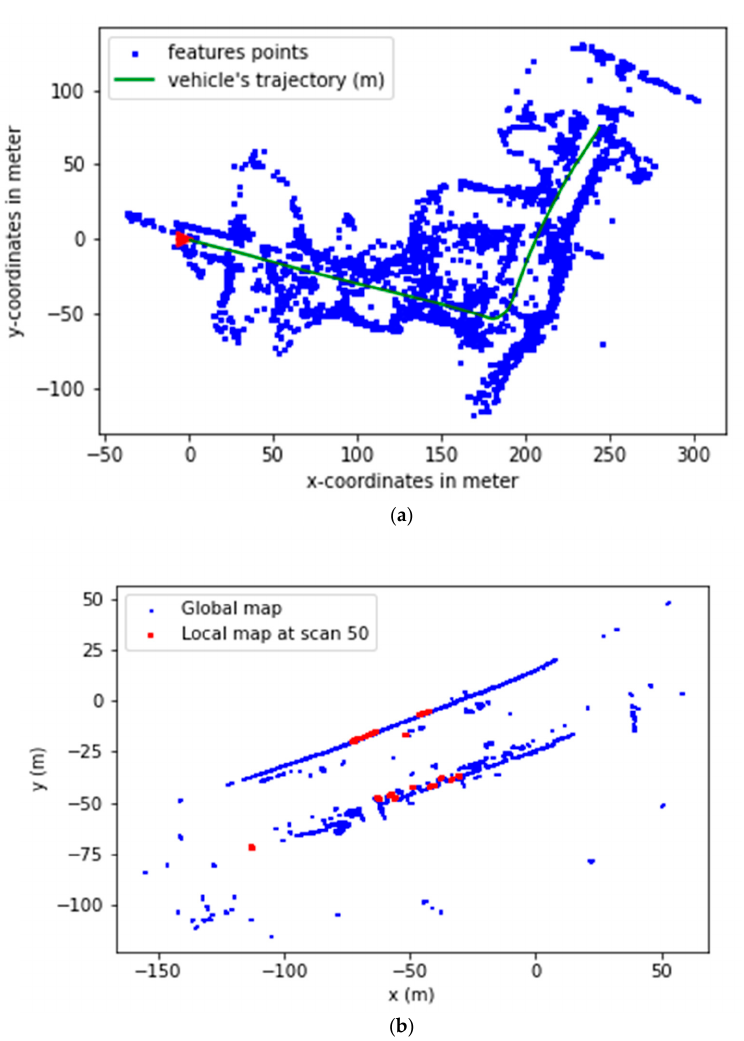
Figure 5. ( a ) The results of the mapping phase after concatenation and transformation. The blue dots are the global features map, the red triangle is the particle initialization, and the green line is the ground truth. ( b ) Example of data association of scan 50 of the sequence 0001 of the Kitti dataset.